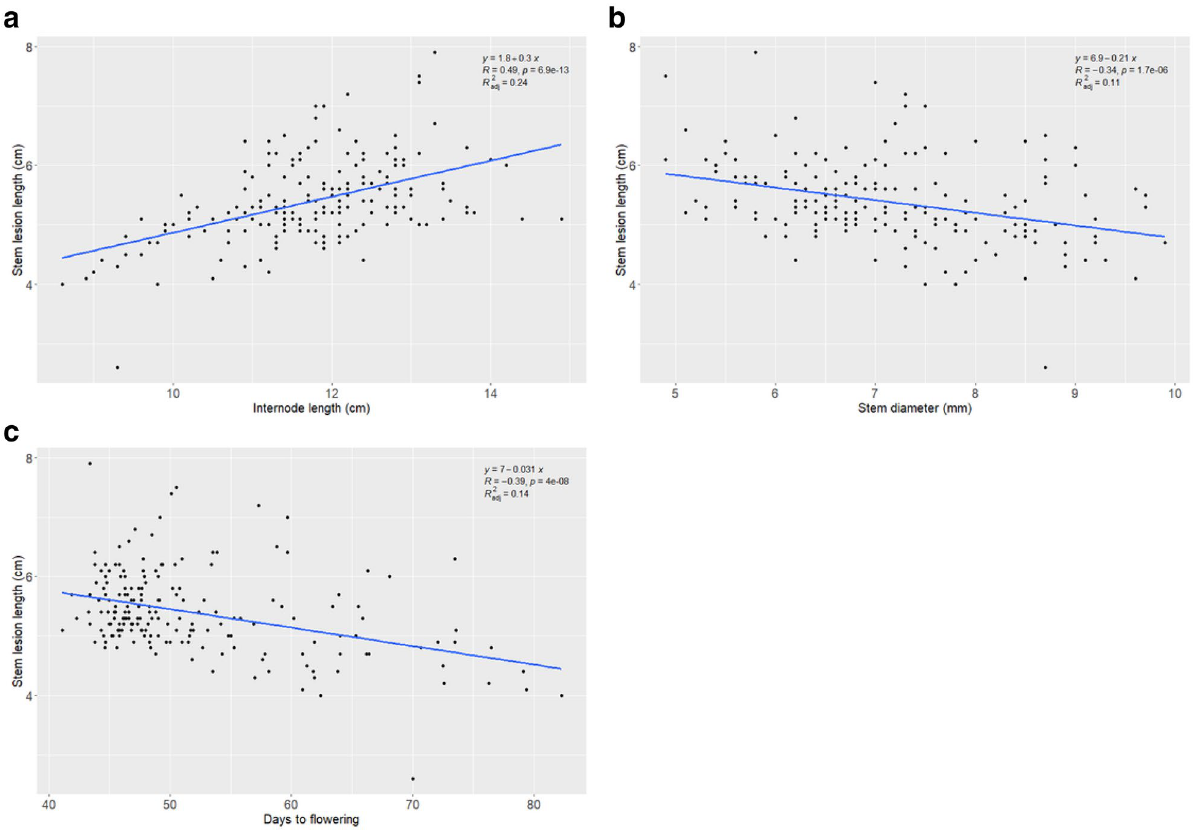
coefficient between the two traits , R 2 ad j is the coefficient of